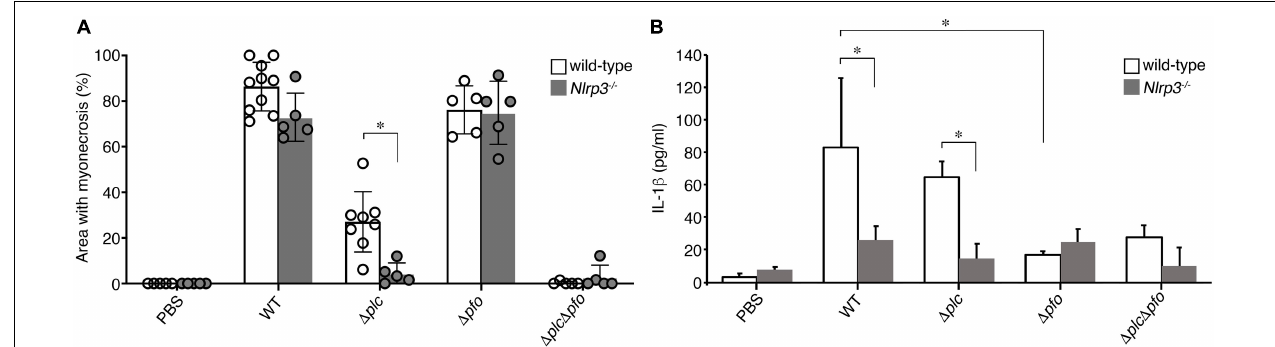
FIGURE 6 | NLRP3-mediated myonecrosis and IL-1 β production. (A) Quantitative analysis of the area of myonecrosis from the data in (A,B) in Figure 5 . (B) IL-1 β production in the infected muscle tissues analyzed by an ELISA. Data are presented as the means ± SD and compared using a t -test ( ∗ p < 0.05).